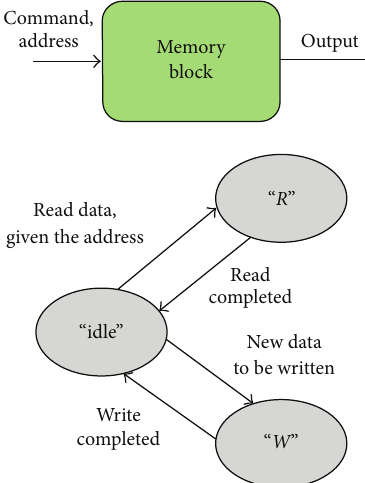
Figure 7: DEVS models of the memory block in the proposed NoC